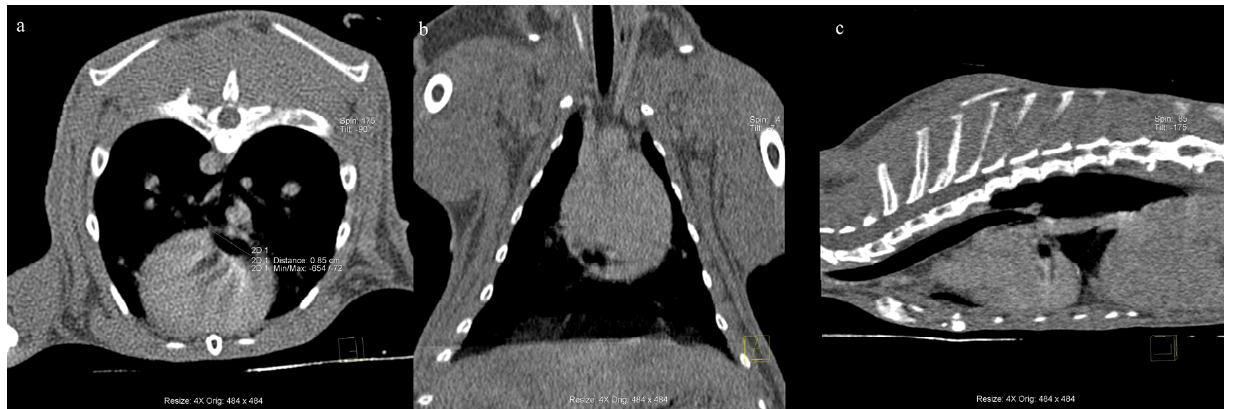
Figure 1. CT scan (native scan). A small amount of gas in the pericardial sac. Axial ( a ), coronal ( b ), and sagittal ( c ) reformat images of the chest computed tomography showing a small amount of gas in the pericardial cavity.